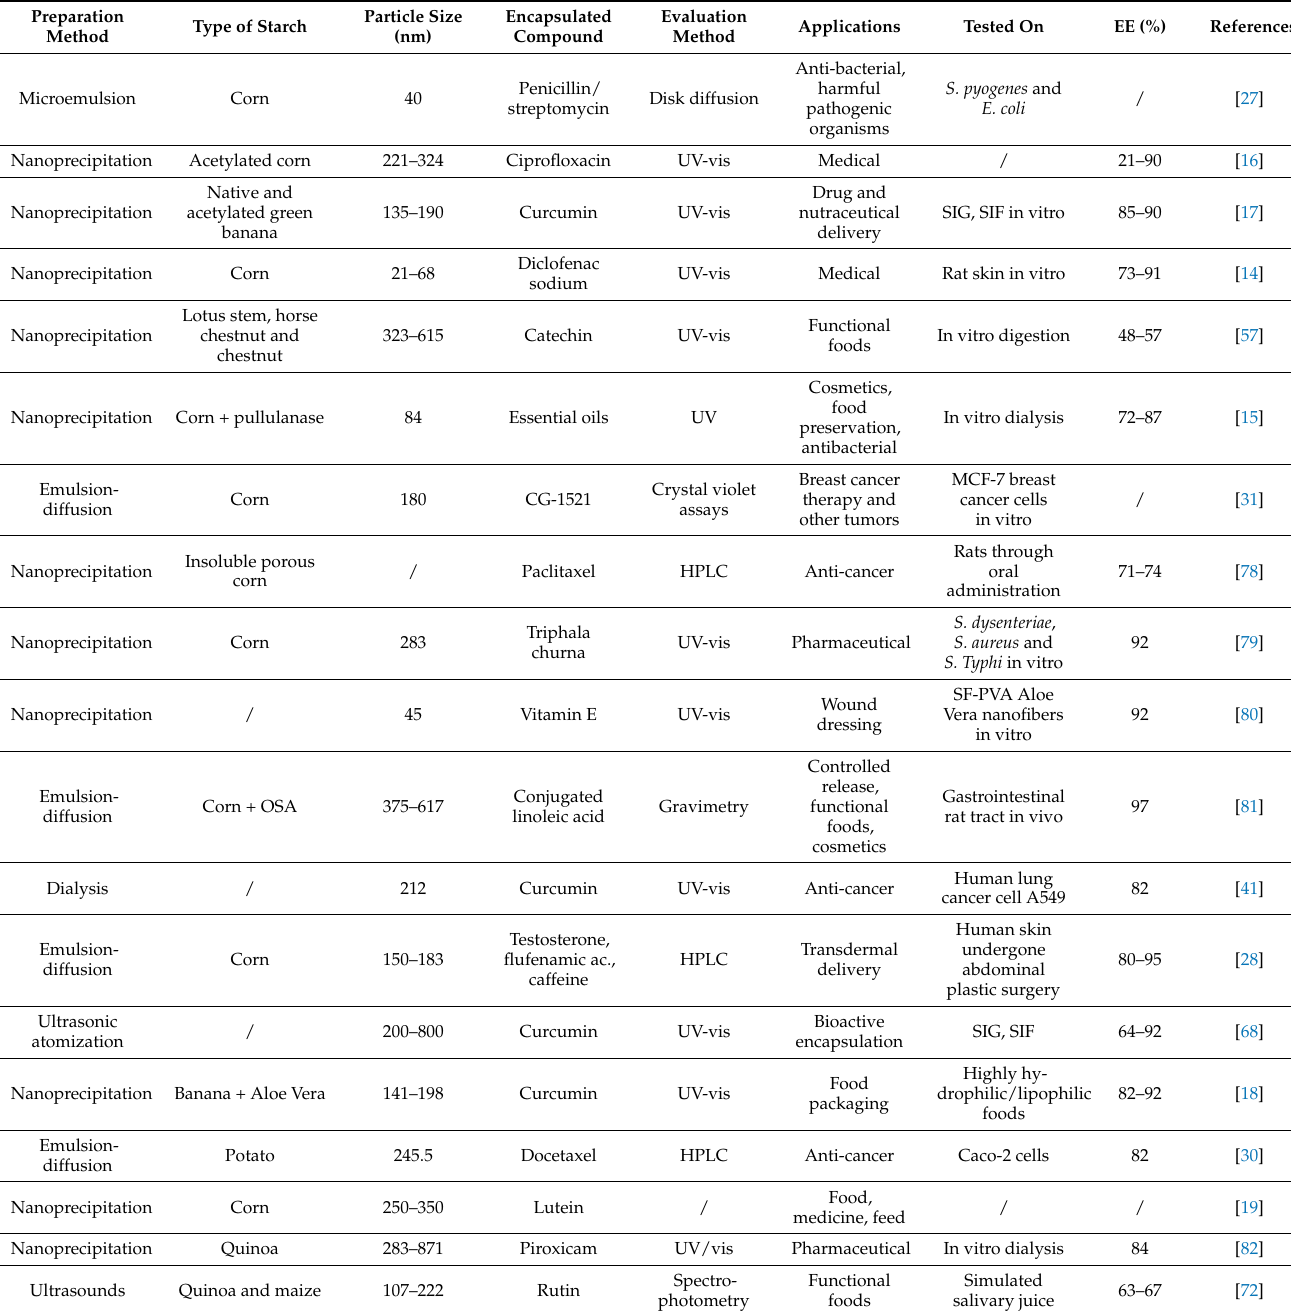
Table 2. Examples of recent studies of SNPs synthesis methods and encapsulation of different compounds through direct